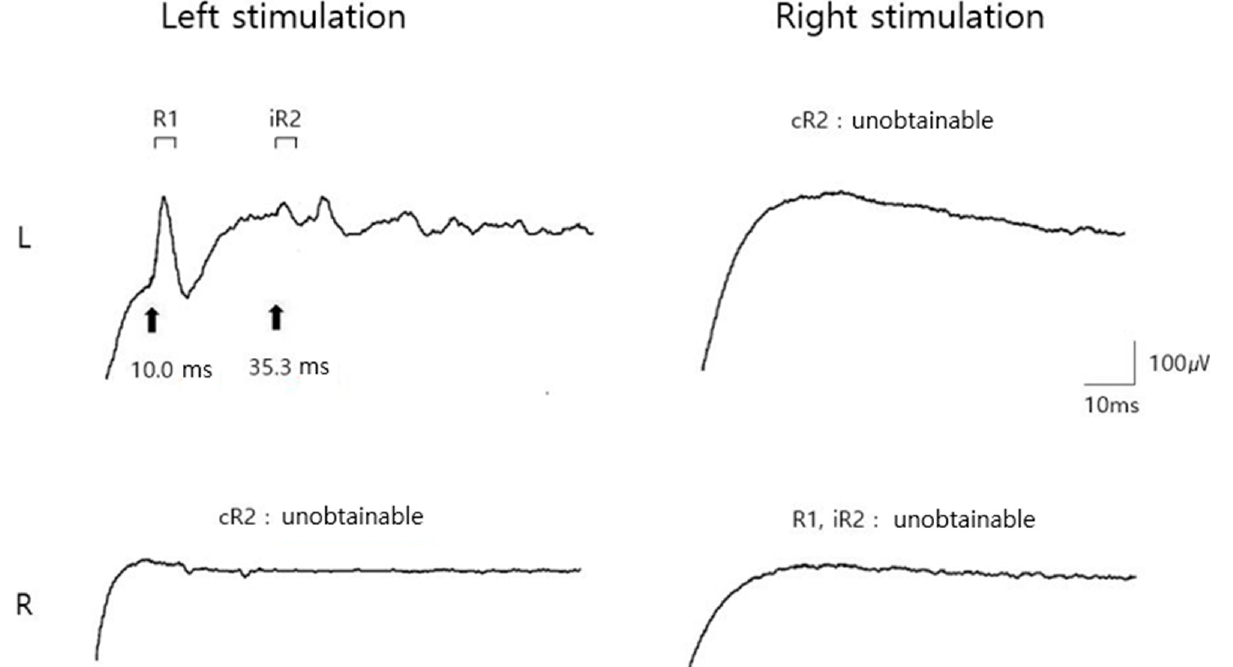
Figure 2. Preoperative blink reflex study results. Stimulation of the left supraorbital nerve provoked normal ipsilateral early wave (R1) and late wave (R2) responses, however did not provoke a con- tralateral R2 response. Stimulation of the right supraorbital nerve did not provoke ipsilateral R1 and R2 and contralateral R2 responses. Abbreviations: iR2, ipsilateral R2; cR2, contralateral R2. One week later, the patient underwent retromastoid suboccipital craniotomy for tu- mor excision. Exposure of the lesion revealed that the tumor mass grossly compressed both the trigeminal and facial nerves. The patient experienced no postoperative compli- cations, and postoperative histopathologic examination confirmed a vestibular schwan- noma. The patient’s neurologic symptoms were partially improved after surgery. How- ever, a brain MRI performed one month after surgery revealed a remnant tumor mass near the right IAC. The patient underwent additional gamma knife radiosurgery for treat- ment of the remnant tumor. One month after gamma knife radiosurgery, the patient showed recovery from the right facial palsy (House–Brackmann grade II). 3. Discussion Cystic vestibular schwannomas can appear on computed tomography or MRI as pe- ripherally thin-walled tumors or centrally located thick-walled tumors. Although these tumors are benign, patients frequently experience rapid progression of facial nerve symp- toms [8]. Clinical presentation is dependent on tumor size at diagnosis, the effect of the tumor mass on the brainstem, and possible obstruction of CSF pathways. In the present patient, severe brainstem displacement and fourth ventricle tumor compression resulted in mild hydrocephalus. Patients with large vestibular schwannomas, including those with stage IV tumors, therefore frequently present not only with auditory neuropathy and ves- tibulopathy, but also with entrapment nerve symptoms caused by pressure on the facial nerve. The incidence of symptoms and the anatomic relationship between the tumor and the respective cranial nerve have been described previously [9]. Generally, vestibular schwannoma-related trigeminal neuropathy is thought to be caused by direct pressure of the tumor on the trigeminal nerve, leading to demyelination of the somatosensory and pain fibers [5,10]. It has been estimated that 1–9.9% of patients with trigeminal neuralgia symptoms are eventually diagnosed with CPA tumors [11]. Alt- hough both cranial nerves in the present patient were directly compressed by the tumor, she lacked the classic provocative features associated with trigeminal neuropathy. Due to a lack of objective methods available to evaluate the cranial nerves, patients are usually diagnosed based on their subjective symptoms, such as facial paralysis, vertigo, dizziness,